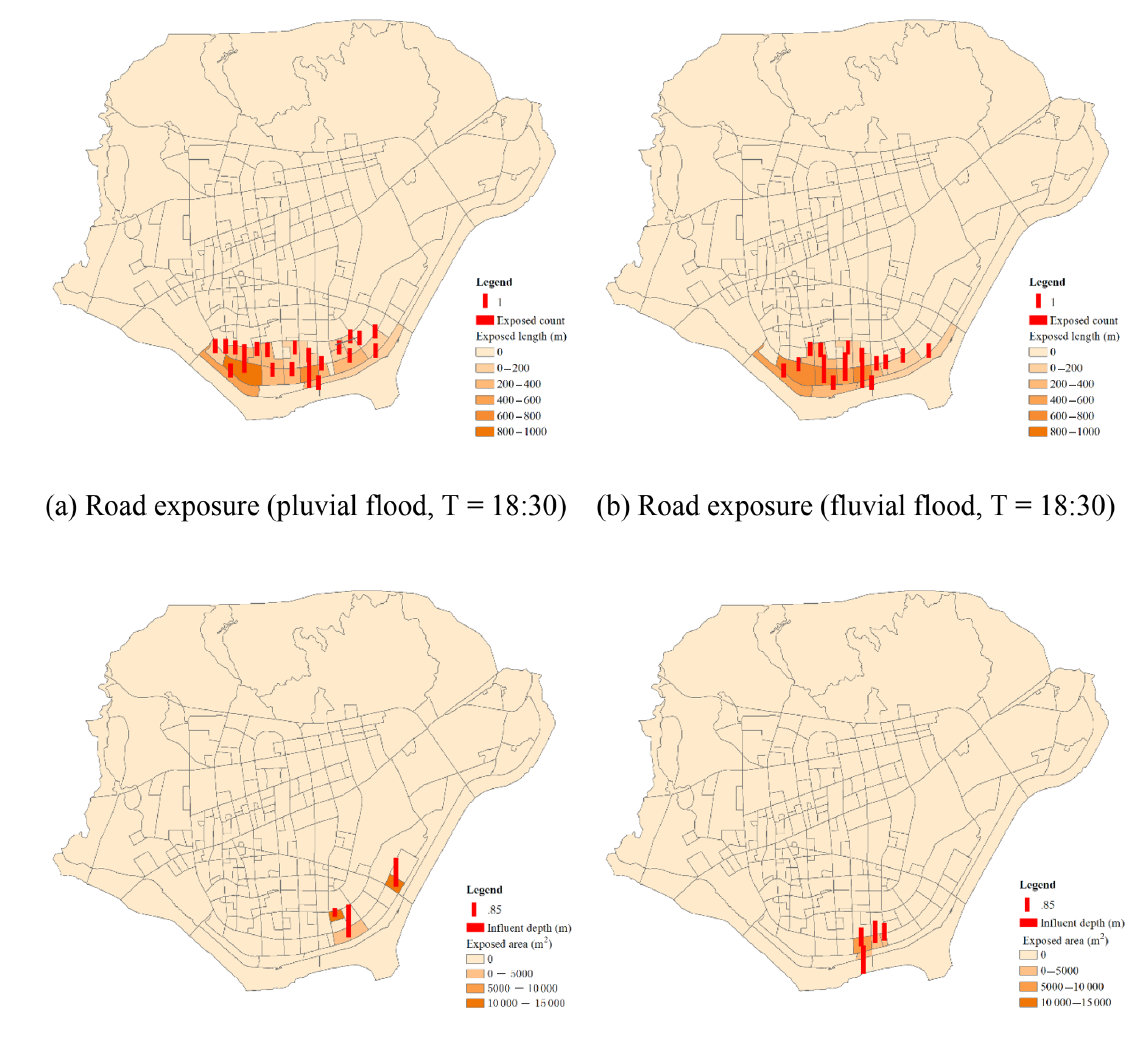
Figure 16. Map of road and building exposures. T means time